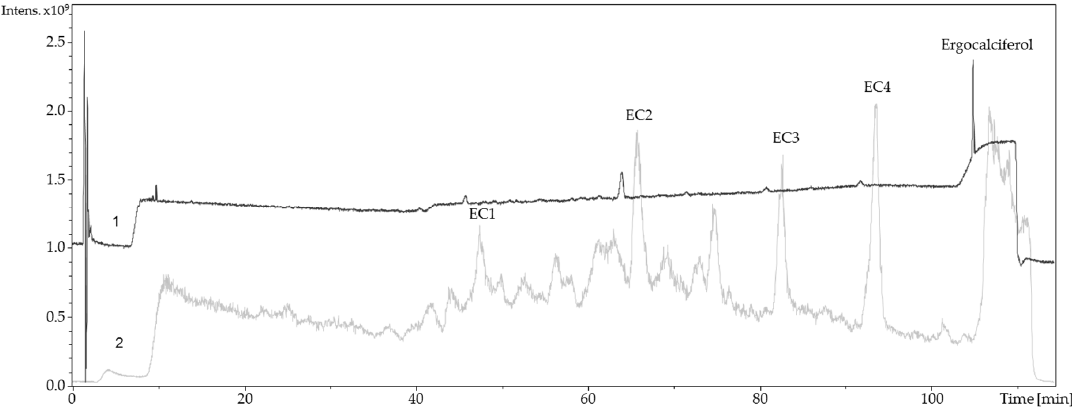
Figure 4. Liquid chromatography coupled to electrospray ionization mass spectrometry and diode-array